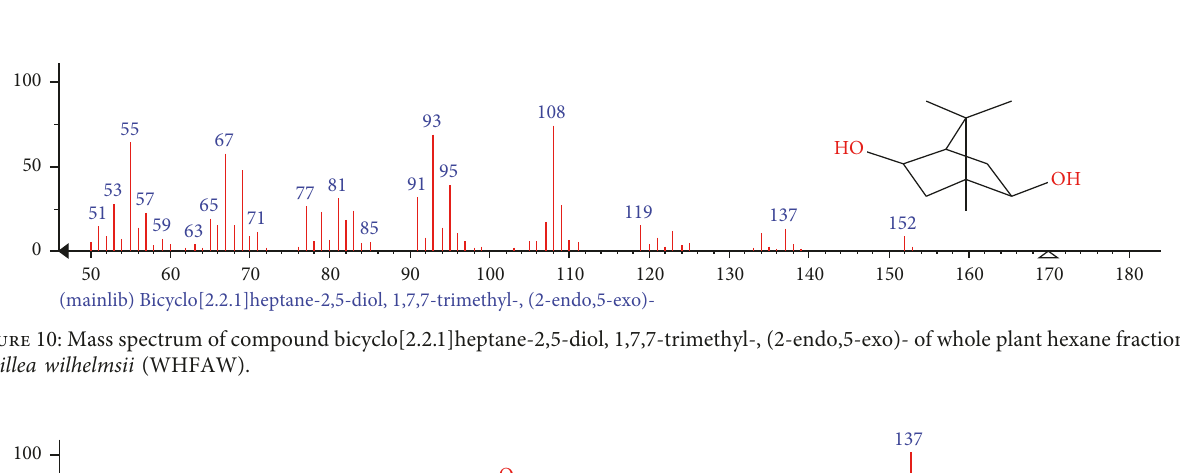
Figure 9: Mass spectrum of compound isopinocarveol of whole plant hexane fraction of Achillea wilhelmsii